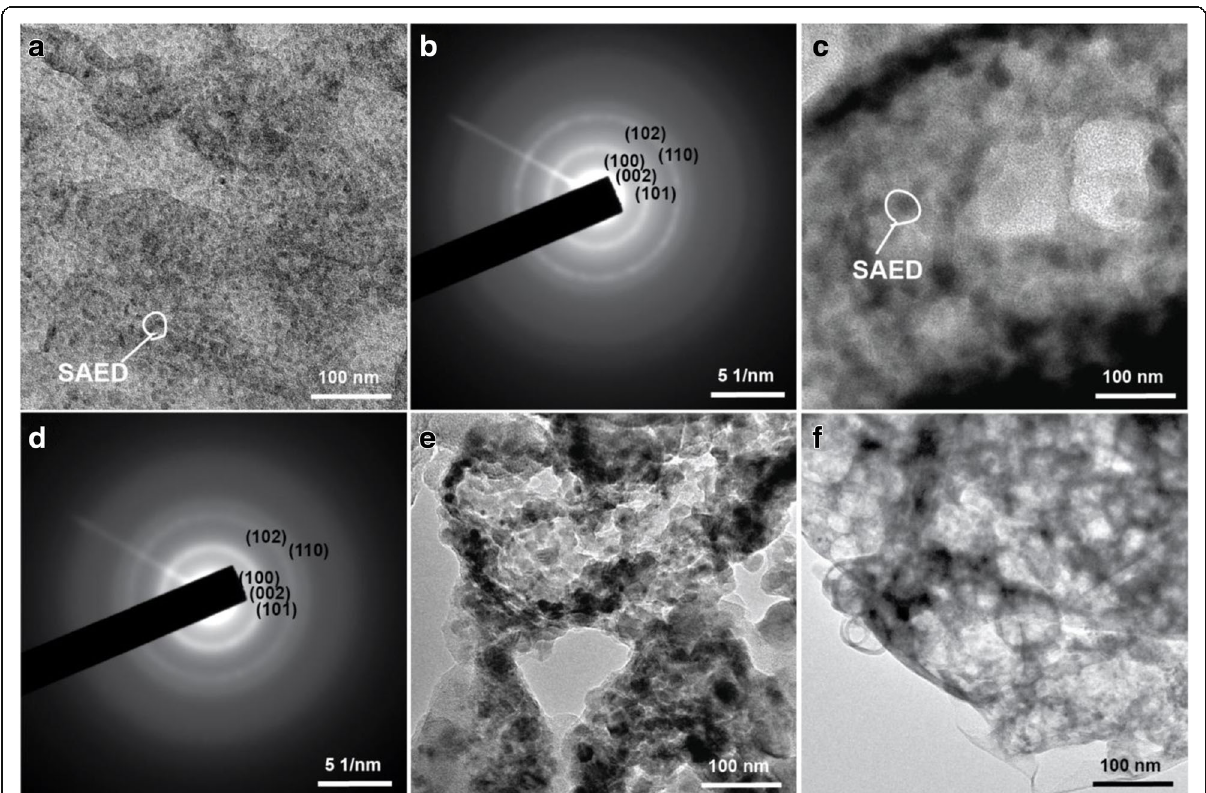
Fig. 6 TEM images ( a , c , e , f ) and SAED patterns ( b , d ) of the ZnO films prepared on PAA with different time of two-step anodization duration a , b 0 min c , d 40 min; e 60 min; and f 80 min